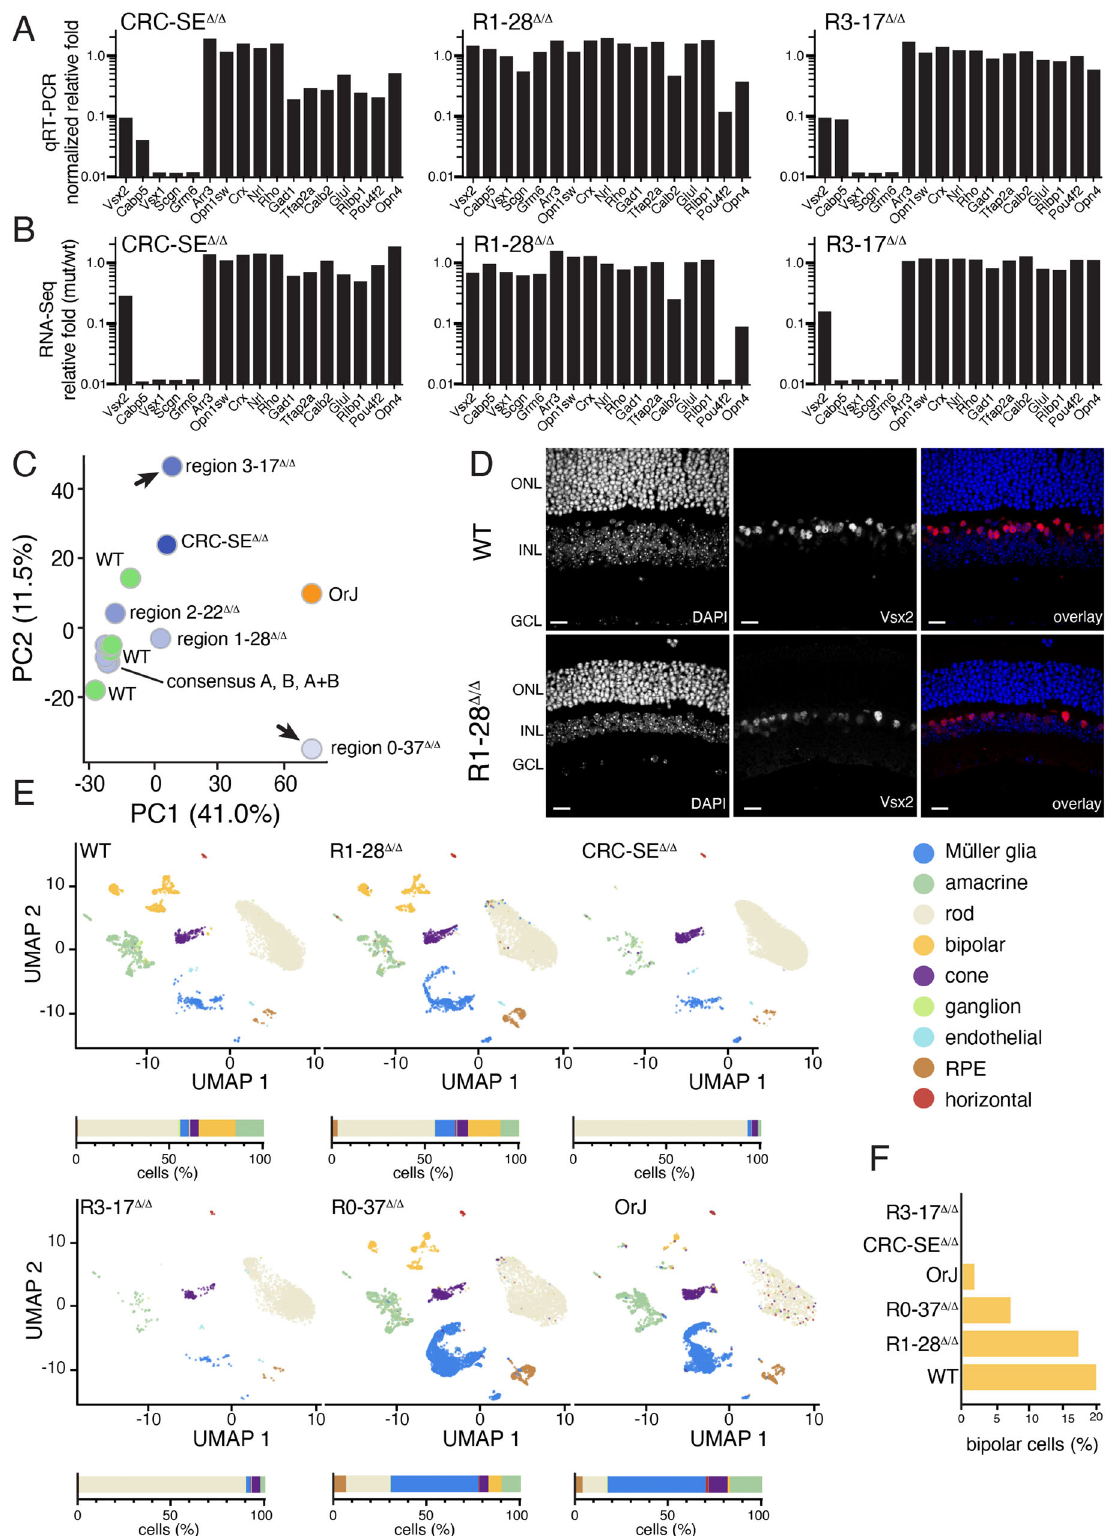
phenotype in the retina from mice lacking those sites. It is pos- sible that the Vsx2 SE is a CRC-SE because the ChIP-seq showed other Vsx2 binding sites that overlapped with Isl1 and Prox1. It is possible that these transcription factors work together at R3-17 to regulate bipolar cell expression of Vsx2. Interestingly, the con- sensus binding sites for Vsx2 in R1-28 were suf fi cient to